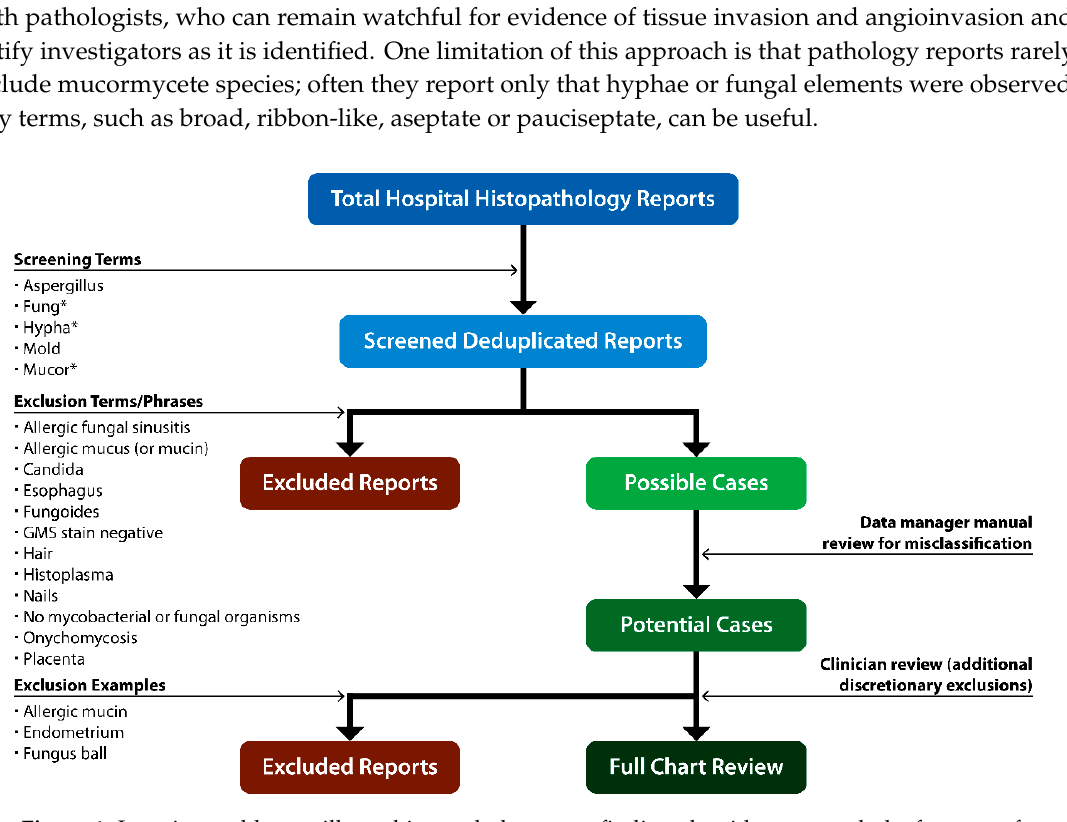
Figure 1. Invasive mold surveillance histopathology case-finding algorithm to search the free text of pathology reports.